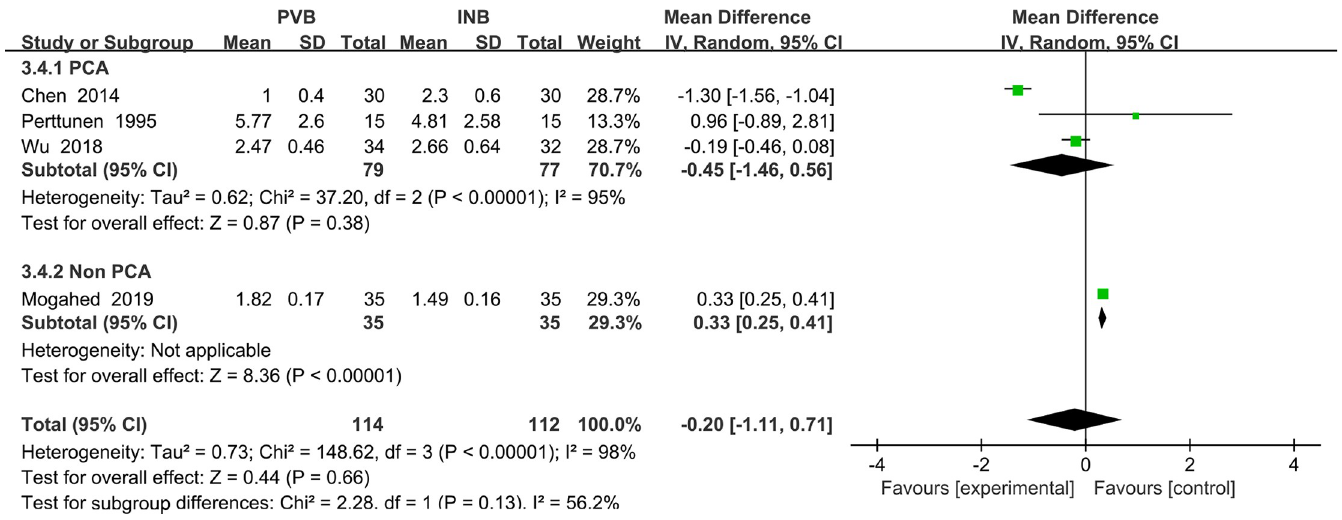
Fig 5. Subgroup analysis of comparison: PCA VS non PCA. Outcome: VAS at rest at the first 1 h.